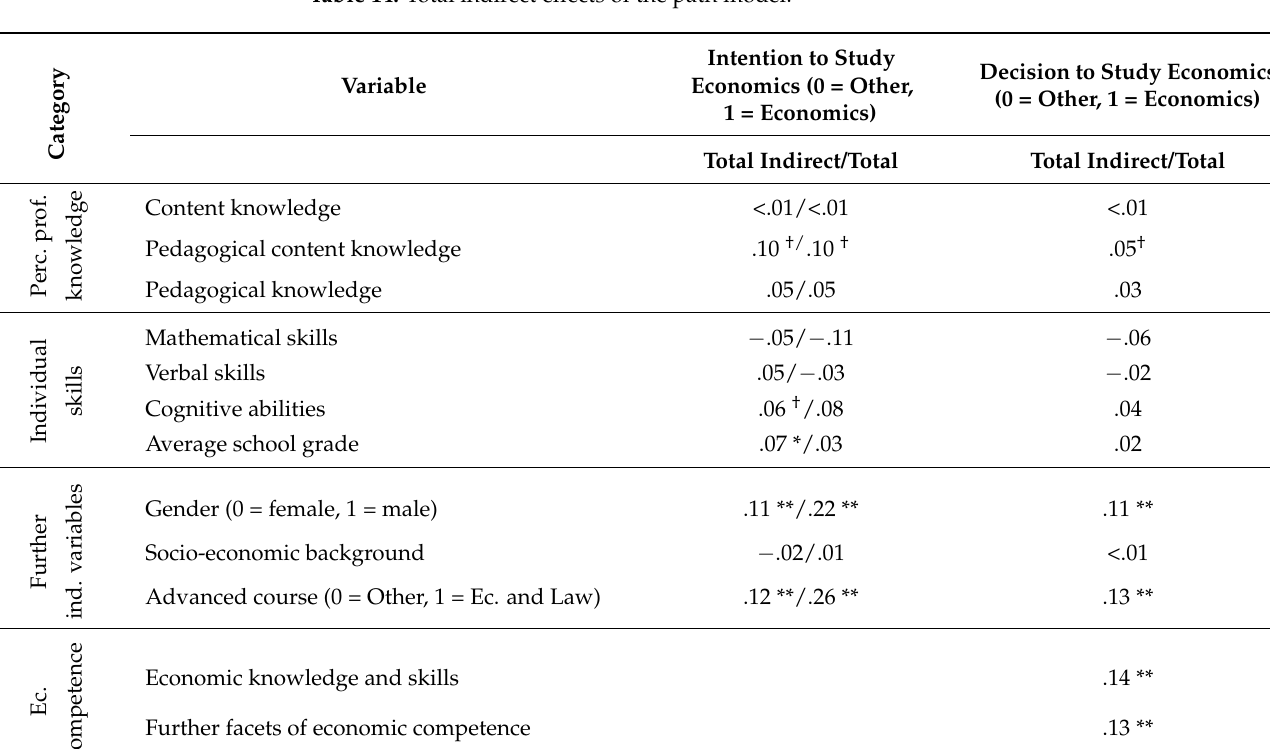
Table 14. Total indirect effects of the path